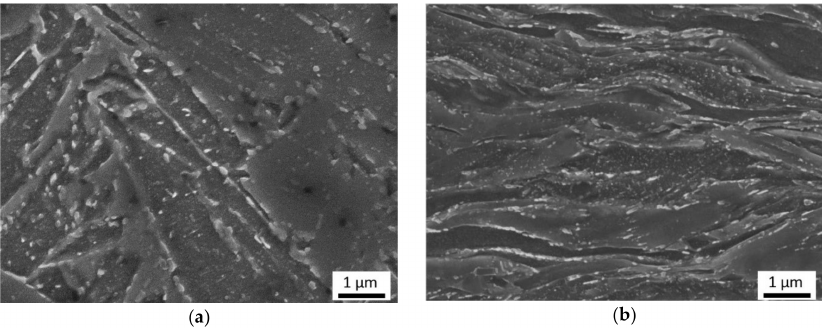
Figure 4. Microstructures of the material 0Cu tempered for 60 min at 500 ◦ C: ( a ) quenched and tempered